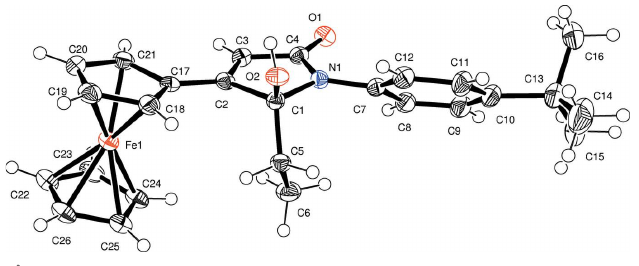
Figure 1 Molecular structure of the S -enantiomer of the title compound showing the numbering scheme. Non-hydrogen atoms are drawn as displacement ellipsoids at the 50% probability level.